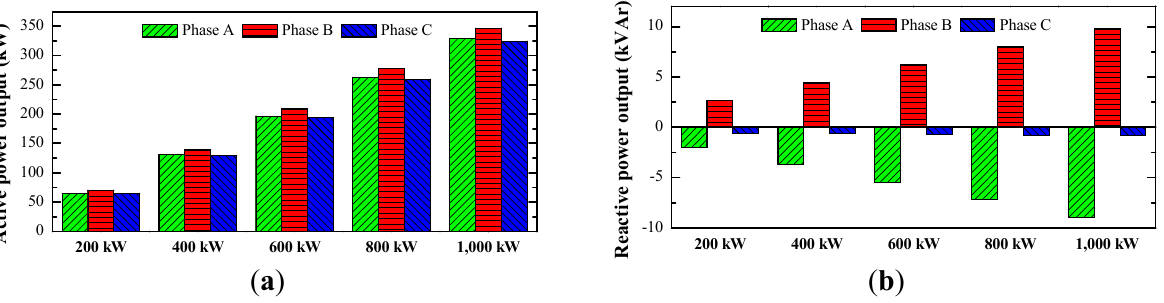
Figure 6. Phase power outputs measured in the PSCAD model: ( a ) active power and ( b ) reactive